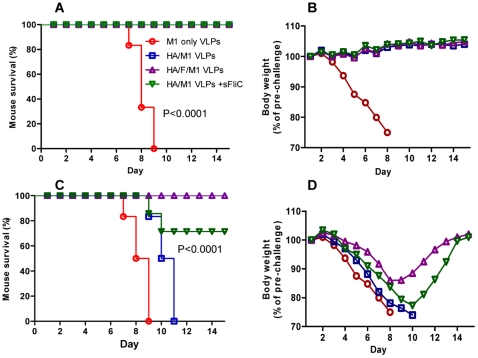
Live virus challenge using A/PR8 (H1N1) or A/Philippines (H3N2) viruses.Immunized mice were challenged with a lethal dose (40 LD50) of A/PR8 (A and B) or A/Philippines (C and D) in a volume of 25 µl by IN instillation. Mouse survival (A, C) and body weight changes (B, D) were monitored daily.